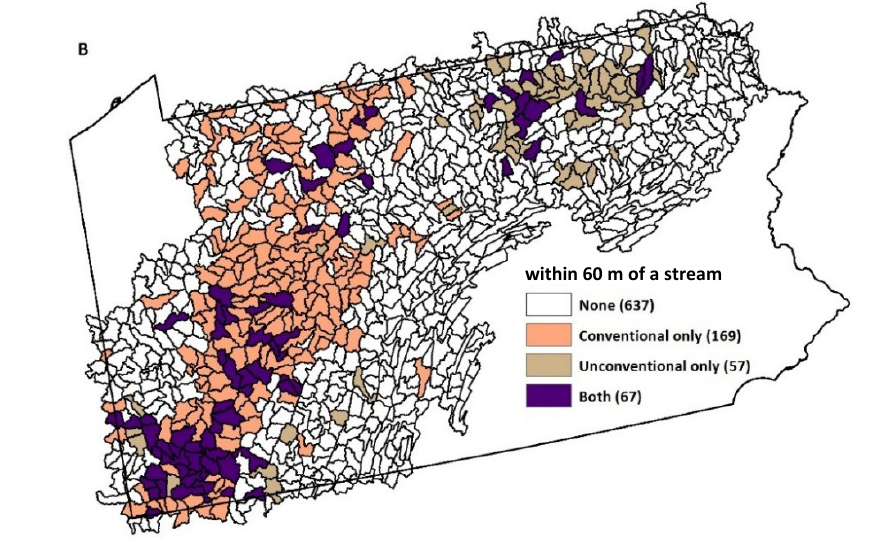
Figure 4. Oil and gas development in close proximity to streams. Values in parentheses are the number of watersheds. ( A ) Conventional and unconventional development within 30 m of a stream; and ( B ) conventional and unconventional development within 60 m of a stream.